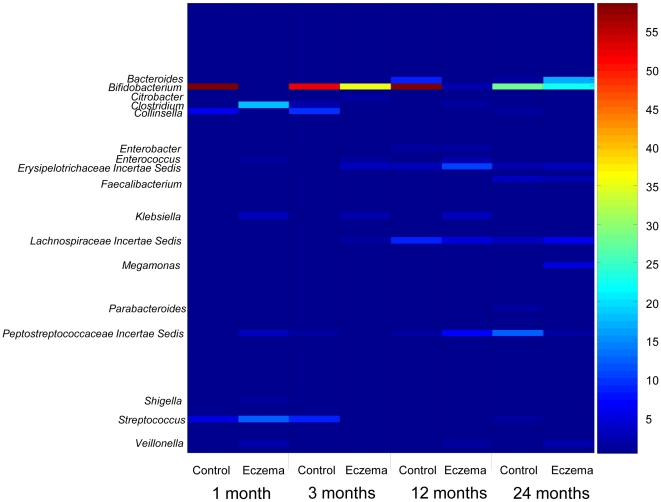
Color-coded heat plot for the microbial succession evaluated at genera level with 454 pyrosequencing.The color intensity of the heat plot denotes the average percentage abundance associated with the bacterial target. Control group denotes the four non-eczema healthy infants, Eczema group denotes the three eczema infants.